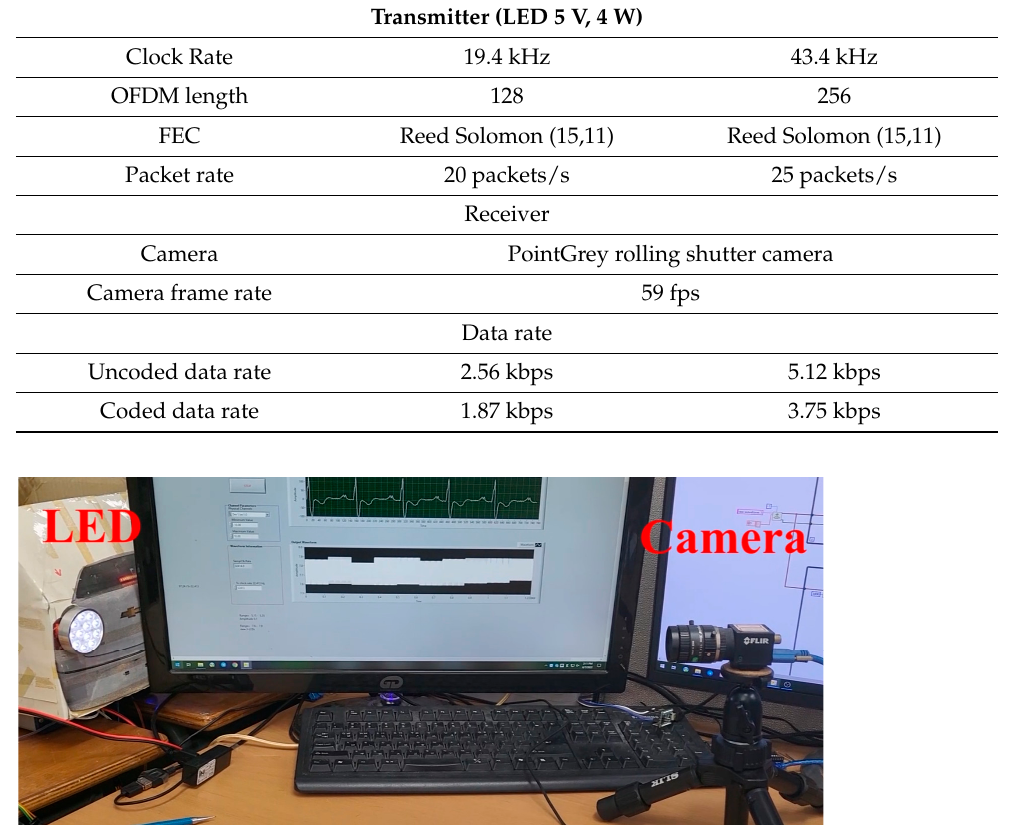
Figure 8. Scenario of RS-OFDM implementation.